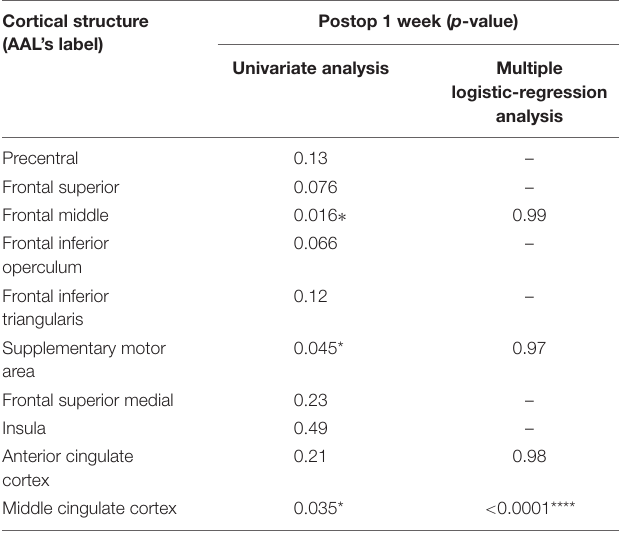
TABLE 2 | Relationship between resected volume of cortical area and attentional deficit.